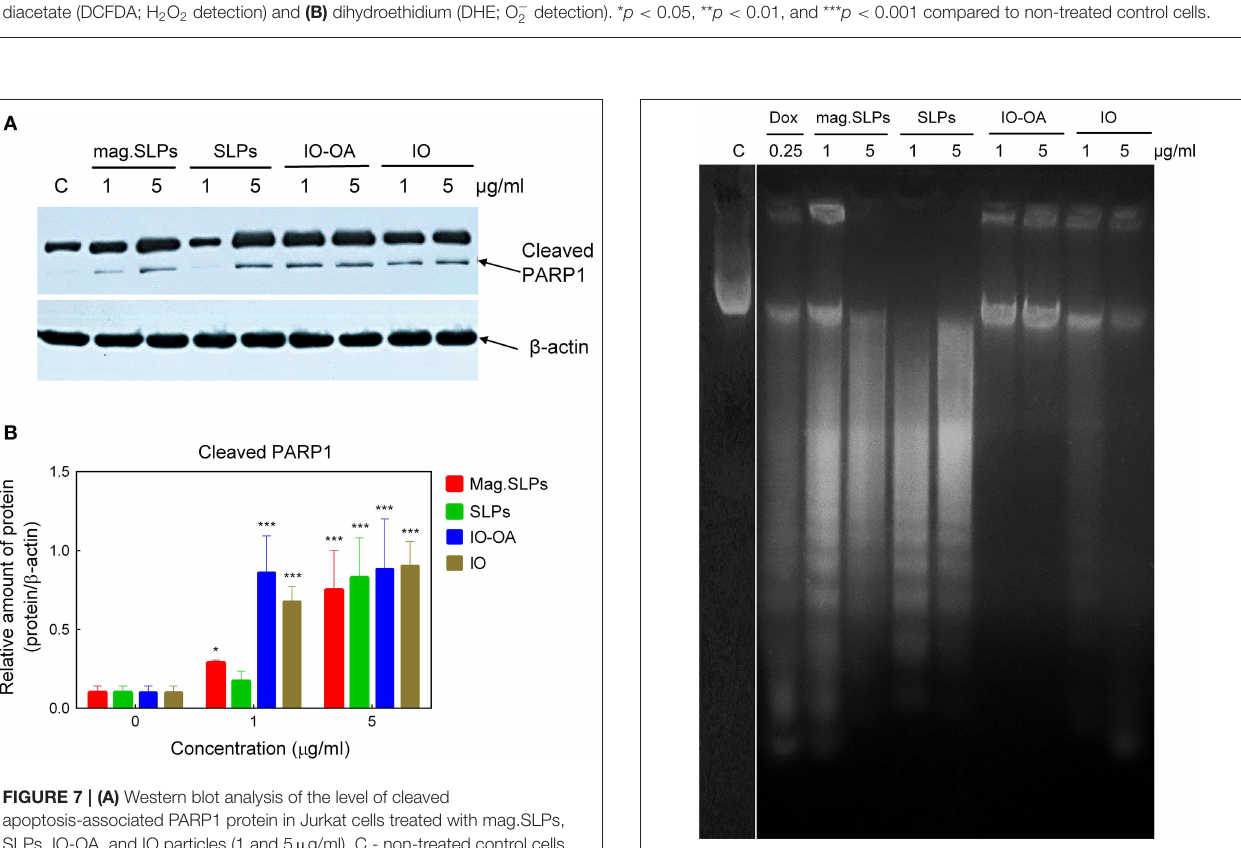
concentration of 1 µ g/ml were relatively non-toxic for Jurkat T- leukemia cells and they did not exhibit a significant impact on cell cycle progression, in contrast to doxorubicin (positive control; 0.25 µ g/ml) that caused a distinct S/G 2 block in the cells. At high dose (5 µ g/ml), the mag.SLPs demonstrated a strong cytotoxic activity with > 76% of Jurkat T-leukemia cells in a pre-G1 phase (apoptosis). At the same concentration, the SLPs killed 69% of the cells and IO-OA or IO (5 µ g/ml) did not induce